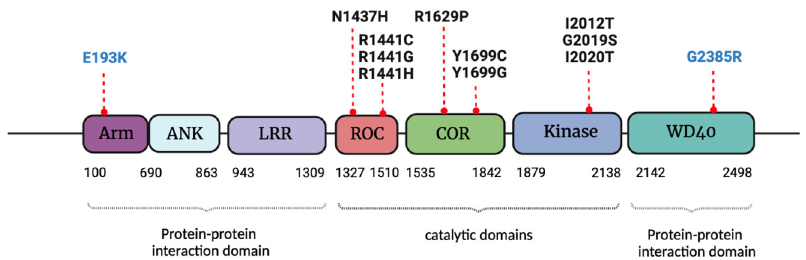
Figure 1. LRRK2 structure. LRRK2 contains seven structural domains, known as armadillo domain (Arm), ankyrin domain (ANK), leucine-rich repeat domain (LRR), ROC domain (Ras of Complex), COR domain (C-terminal of ROC), kinase domain (kinase) and WD40 repeat domain (WD40). PD associated-LRRK2 mutations and risk factors are indicated with a red line above the specific structural domain.